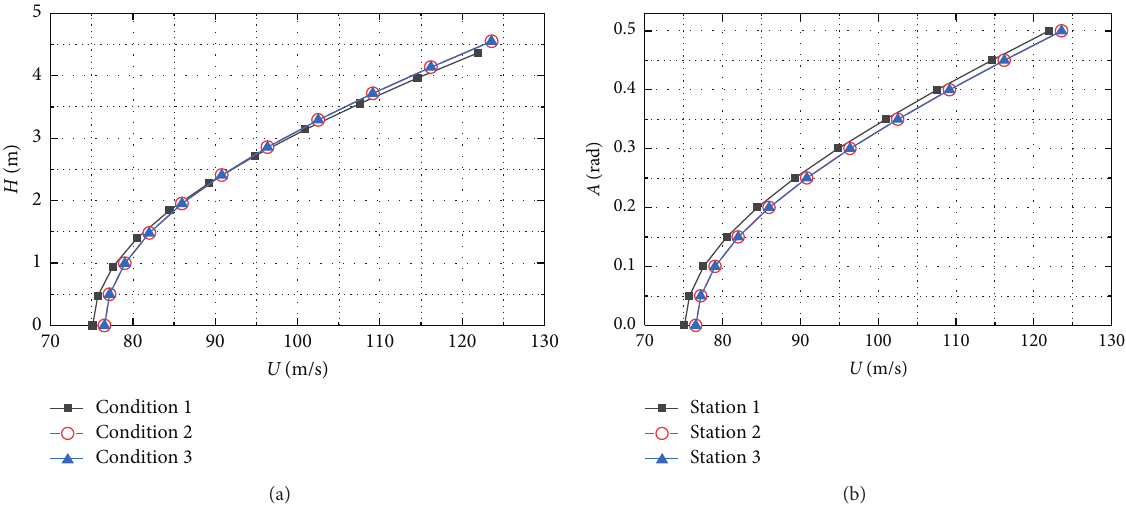
Figure 11: Curves of wind speed and amplitudes of LCOs in three conditions. (a) U vs. H . (b) U vs. A